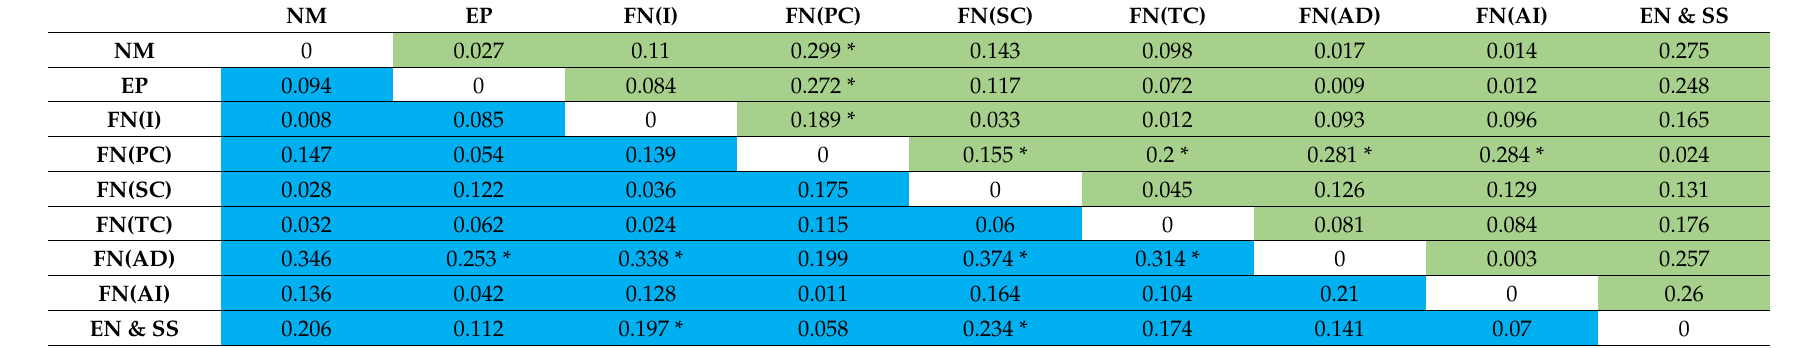
C. SOCIAL RISK—BI Relationship is Indicated in Blue Colour; PRIVACY RISK—BI Relationship is Indicated in Orange Colour